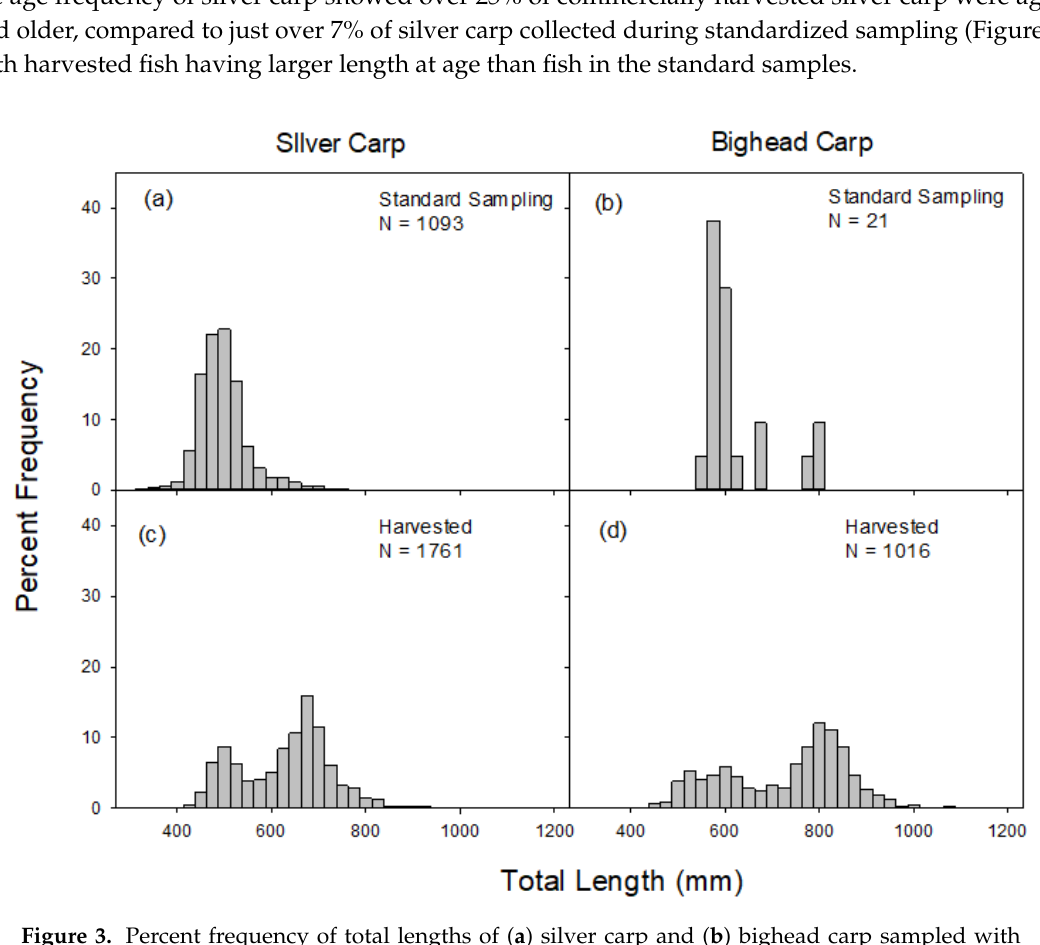
Figure 3. Percent frequency of total lengths of ( a ) silver carp and ( b ) bighead carp sampled with standardized gear (upper panels) and harvested by fishers ( c , d ) in the lower Illinois River during 2012.